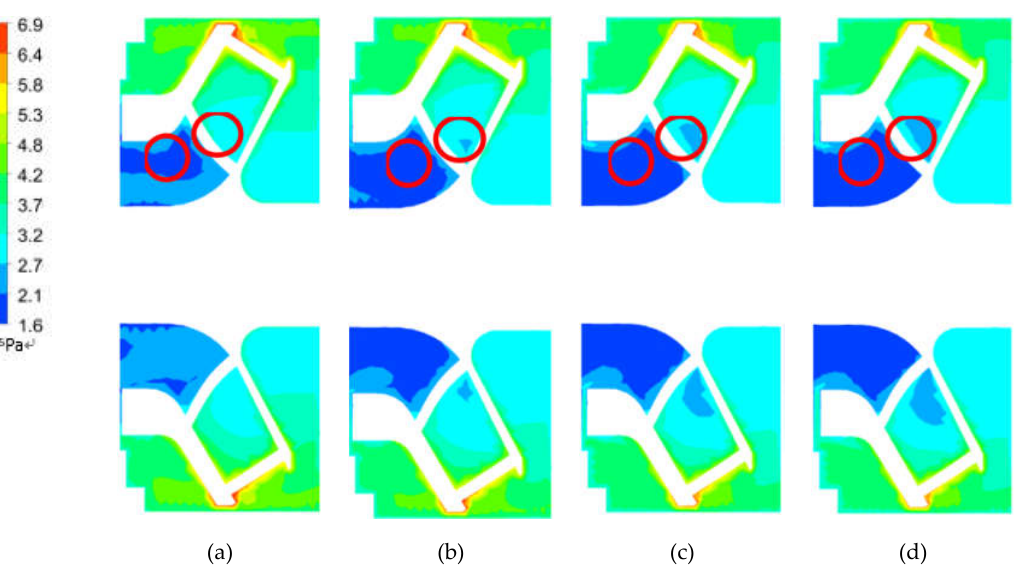
Figure 11. Total pressure contour of second-stage impeller, ( a ) 0.3 mm, ( b ) 0.6 mm, ( c ) 0.9 mm, ( d ) 1.2 mm.